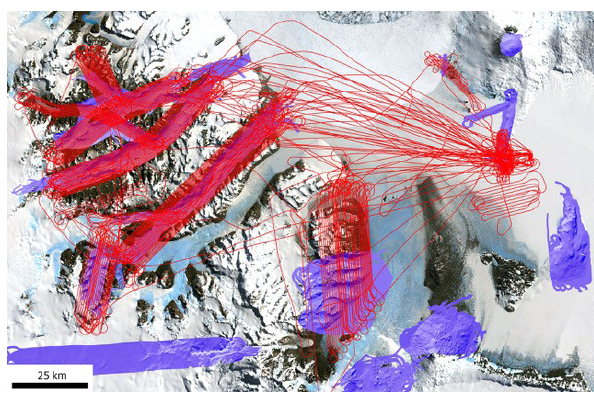
Figure 4. Flight lines for the new 2014–2015 survey (shown in red) over the extent of the 2001 survey (shown in purple) digital eleva- tion model hillshades. Base map is the Landsat Image Mosaic of Antarctica (Bindschadler et al., 2008).